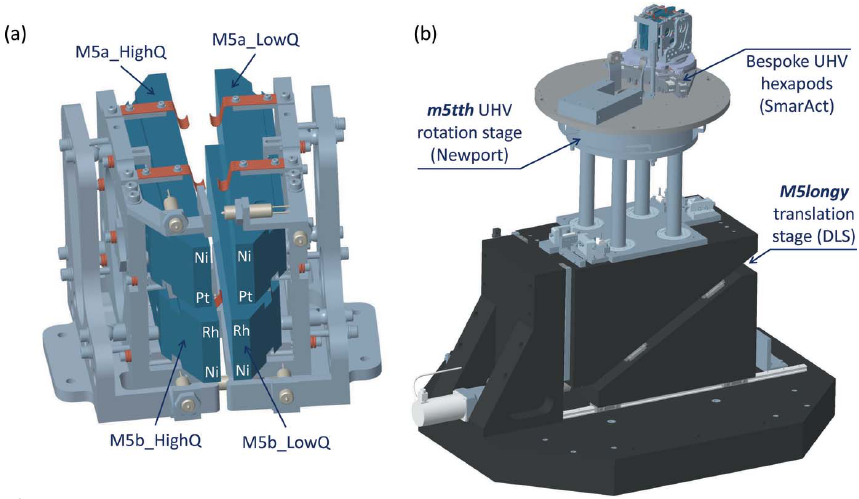
Figure 15 The I21 M5 collection mirror mechanics. Panel ( a ) is a rendering of the M5 optics and the mirror holders, while ( b ) shows the whole M5 mirror